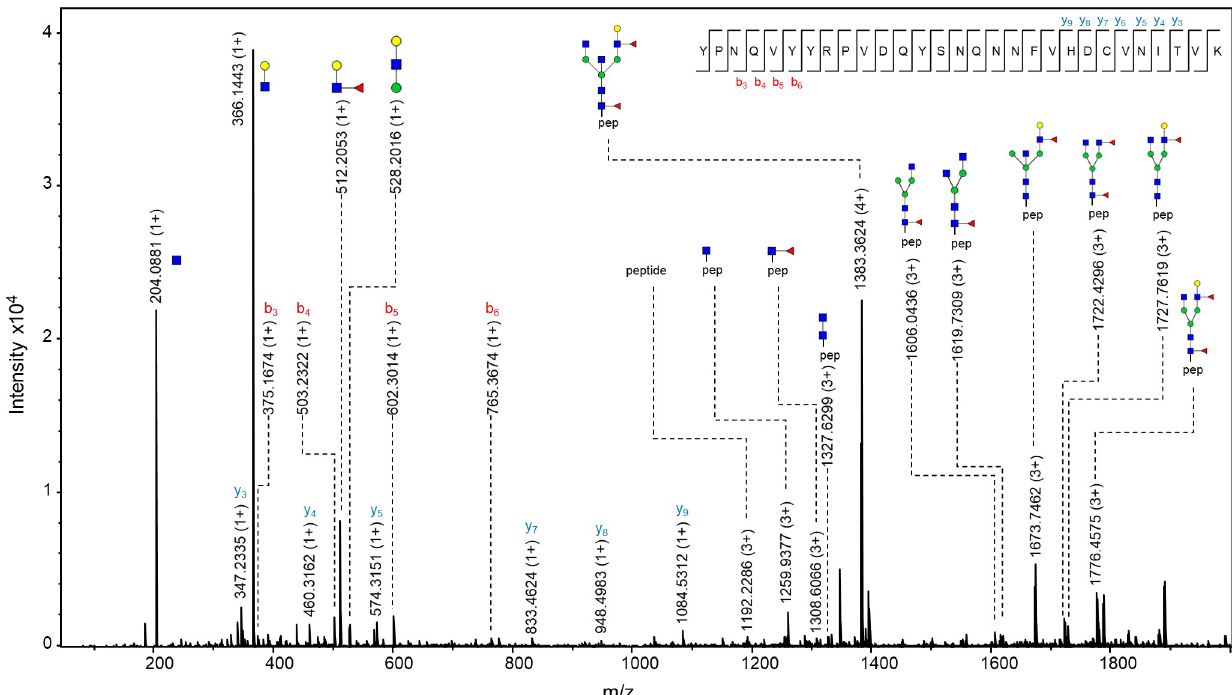
Fig 4. MS/MS spectrum of N-184 glycopeptide from 21K slow prion strain. The glycopeptide represented in the figure is the one carrying N-glycan with a composition H4N5F2, which was found to be the most abundant structure on this glycosylation site. Fragments of glycan-specific marker ions are represented, together with b and y ions confirming the amino acid sequence of N-184 peptide, and fragments of the peptide backbone with the N-glycan. Blue square– N -acetylglucosamine (GlcNAc), green circle–mannose (Man), red triangle–fucose (Fuc), yellow circle–galactose (Gal), purple diamond– N - acetylneuraminic acid (Neu5Ac).